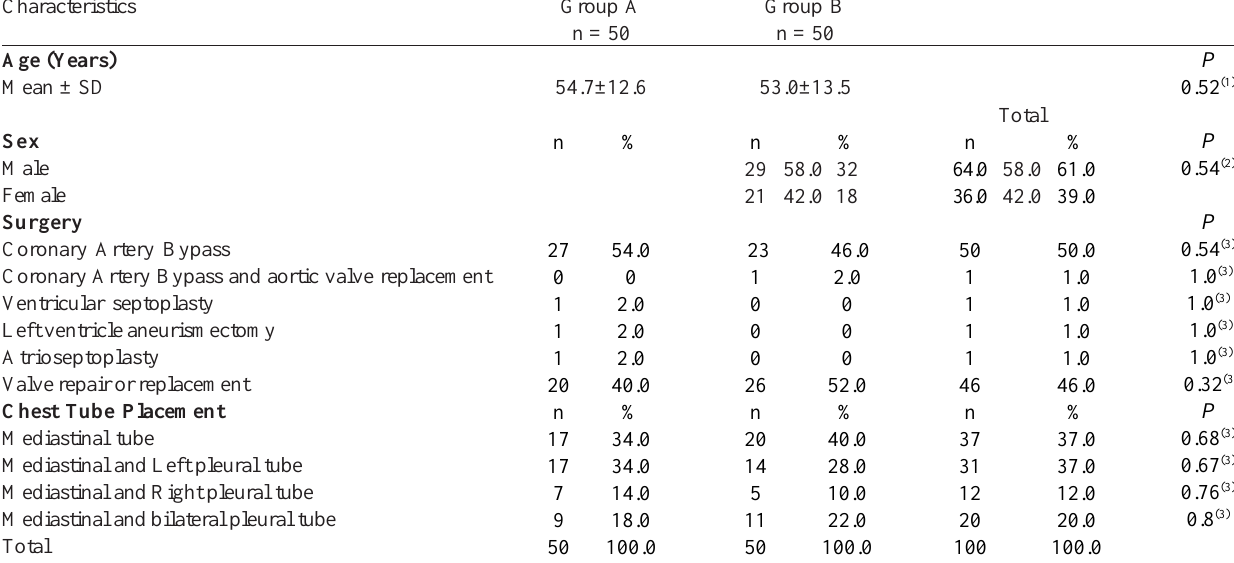
Table 2. Patient and perioperative characteristics in PCA alone (Group A) and PCA plus basal infusion (Group B)